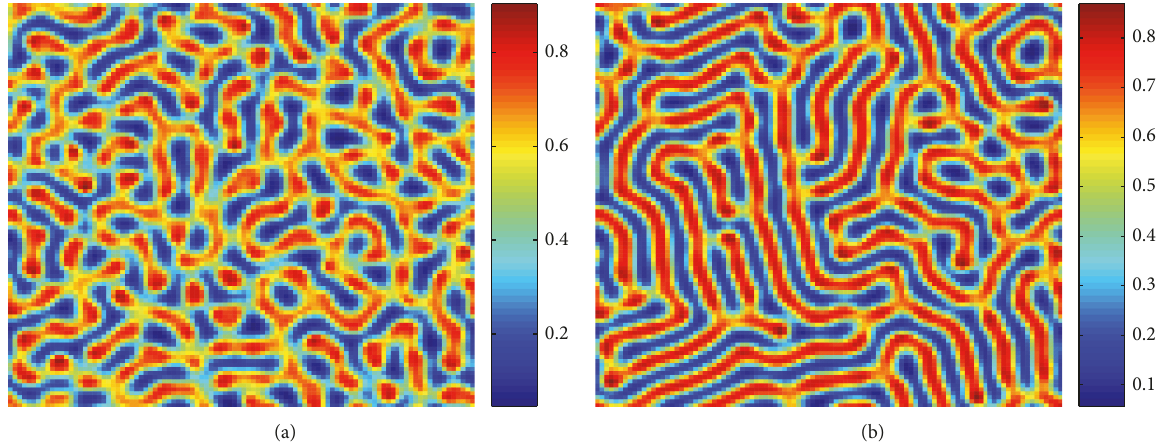
Figure 7: Formation of labyrinth vegetation pattern. 𝐴 = 1.65 × 10 −3 . (a) 𝑇 =2000; (b) 𝑇 =10000.